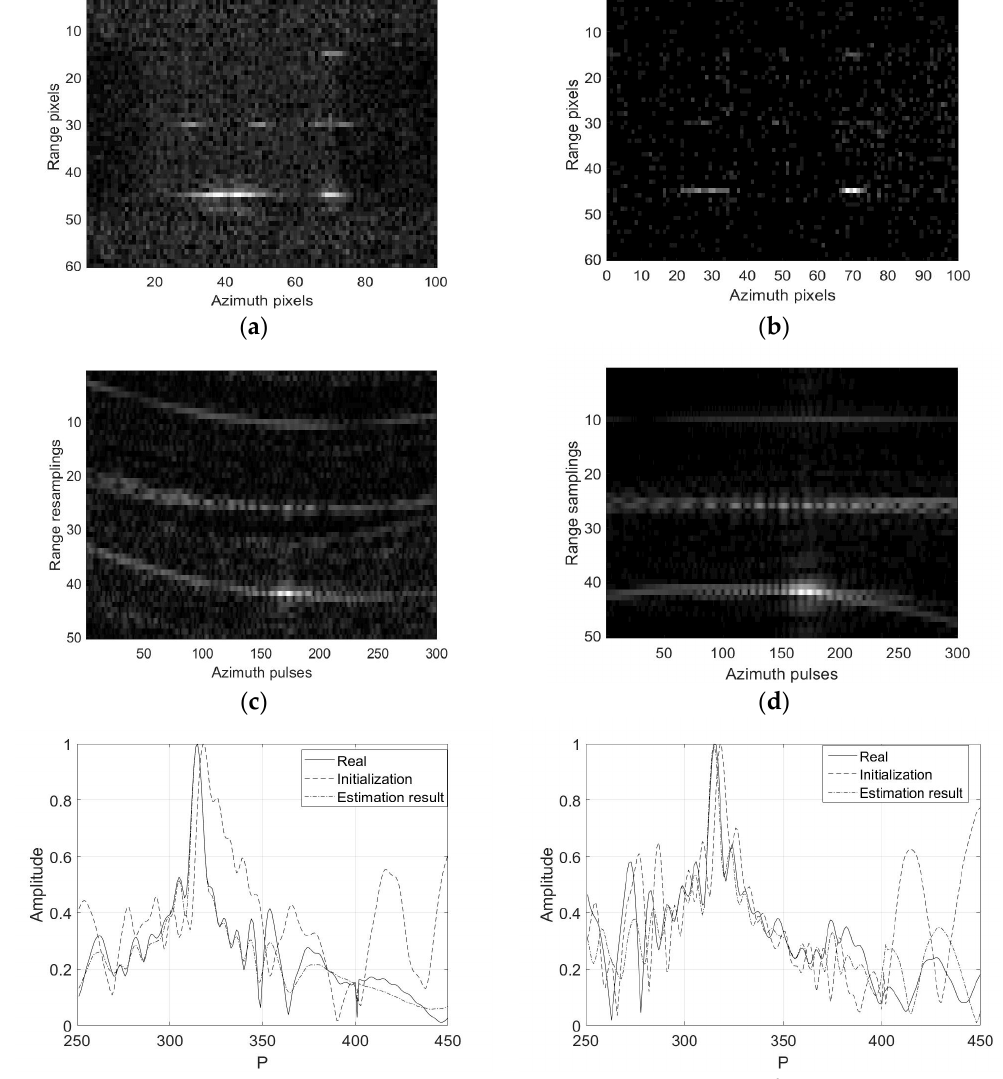
Figure 5. Initialization and Doppler rate estimation results. ( a ) initialized MT imagery, ( b ) reconstructed MT imagery after the first iteration, ( c ) reconstructed MT radar data, ( d ) reconstructed MT data after RCMC, ( e ) Doppler estimation results of MT1, and ( f ) Doppler estimation results of MT5.